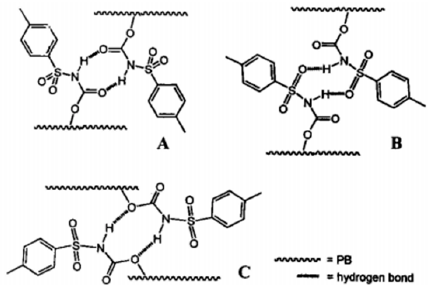
Figure 5. Schematic representation of three possible hydrogen-bonding complexes between two sulfonyl urethane groups (SU) grafted to the polybutadiene chains (PB). (Reprinted (adapted) with permission from [43]. Copyright [43] American Chemical Society).